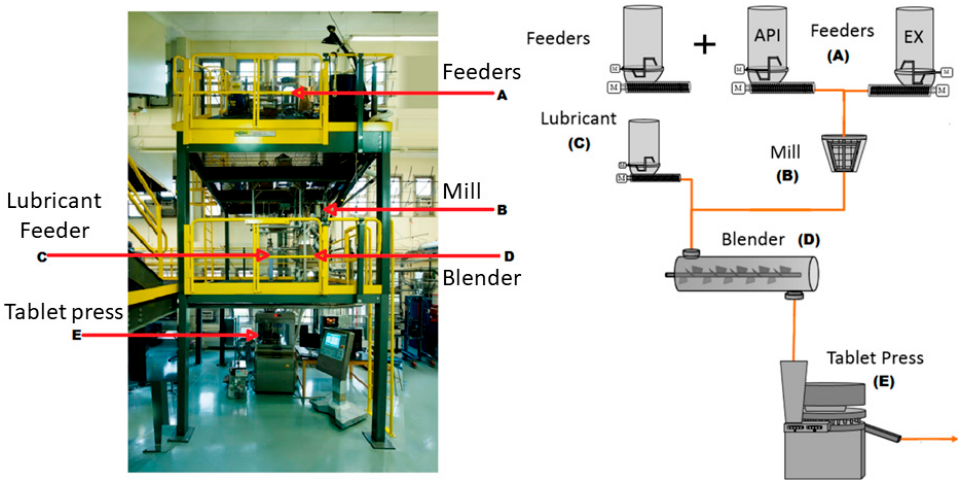
Figure 1. Direct compaction pilot plant.